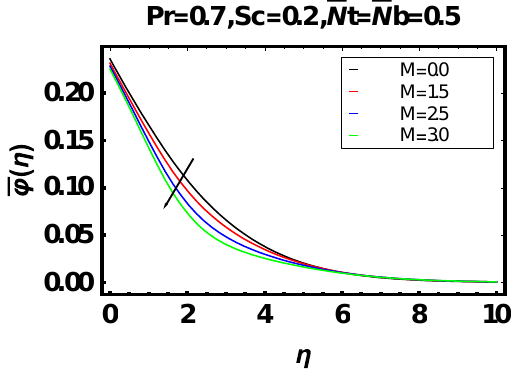
Figure 13. Mass Concentration profile for variant M.